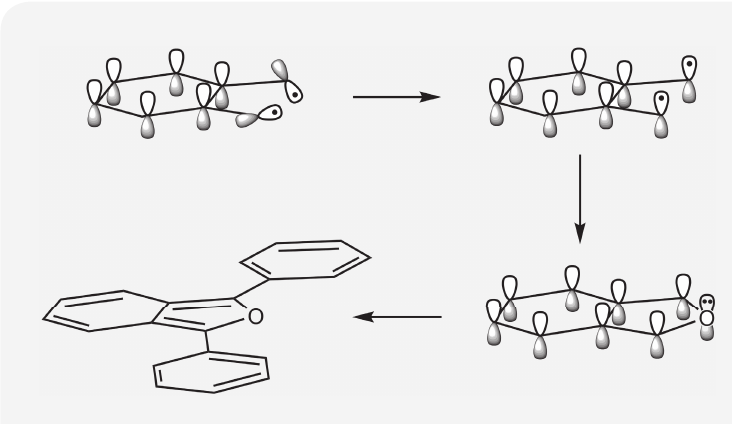
Figure 1. Formal derivation of 1,3-diphenylisobenzofuran from a nearly perfect biradical.